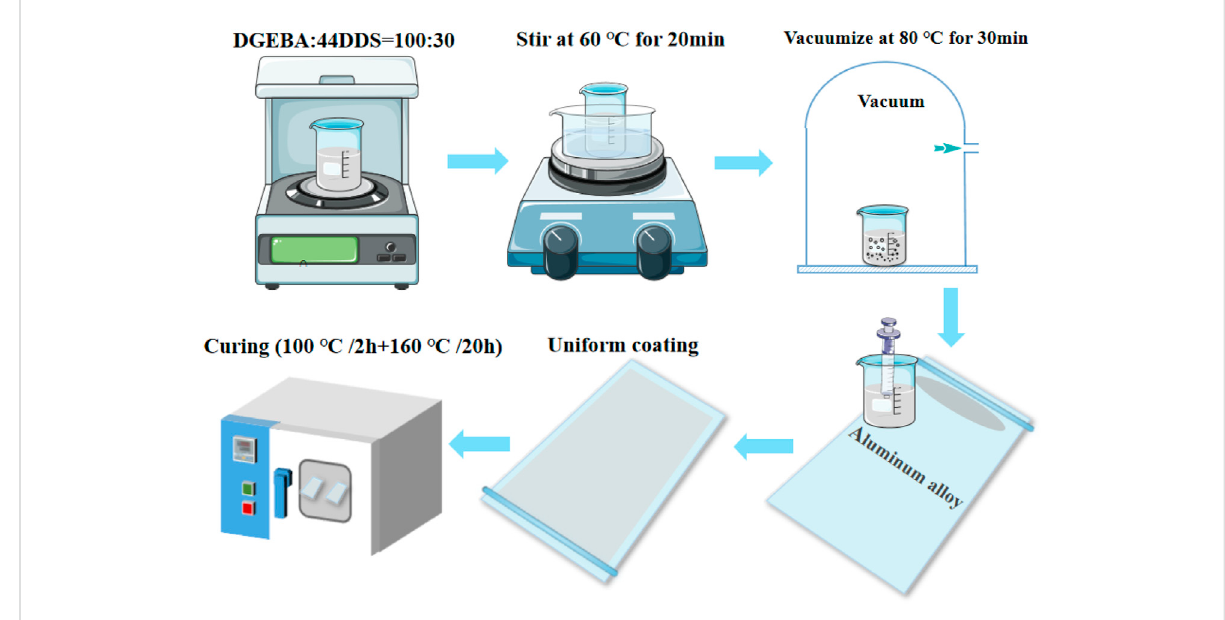
FIGURE 3 Curing fl ow chart of DGEBA and 44DDS on aluminum